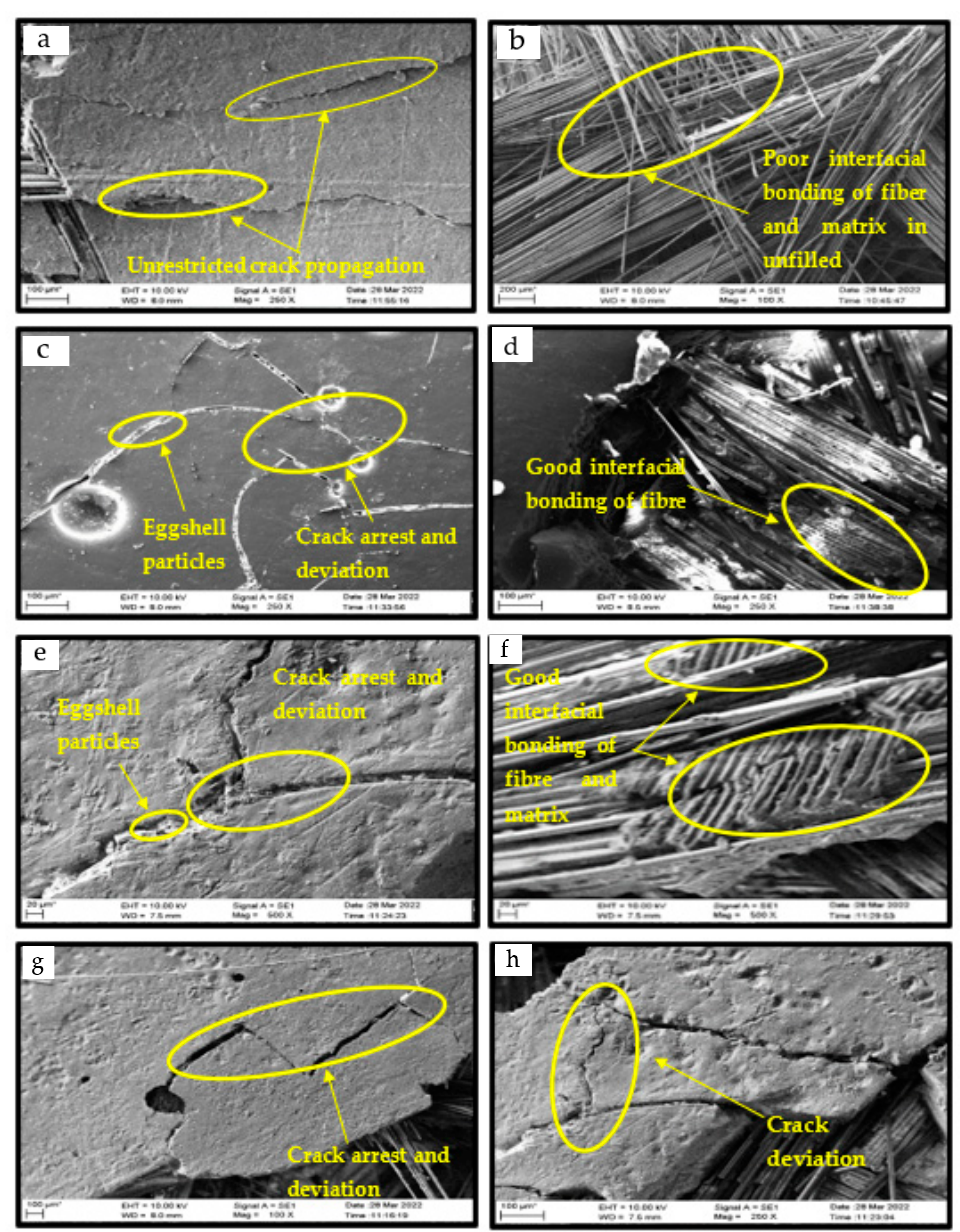
Figure 11. SEM images of composite variants. ( a ) Unrestricted crack propagation in unfilled com- posite; ( b ) poor interfacial bonding of fibre and matrix in unfilled composite; ( c ) crack arrest and deviation in uncarbonised eggshell filled composite; ( d ) good interfacial bonding in carbonised eggshell filled composite; ( e ) crack arrest and deviation in carbonised eggshell filled composite; ( f ) good interfacial bonding in carbonised eggshell filled composite; ( g ) crack arrest and deviation in hybrid eggshell filled composite; ( h ) crack deviations in hybrid